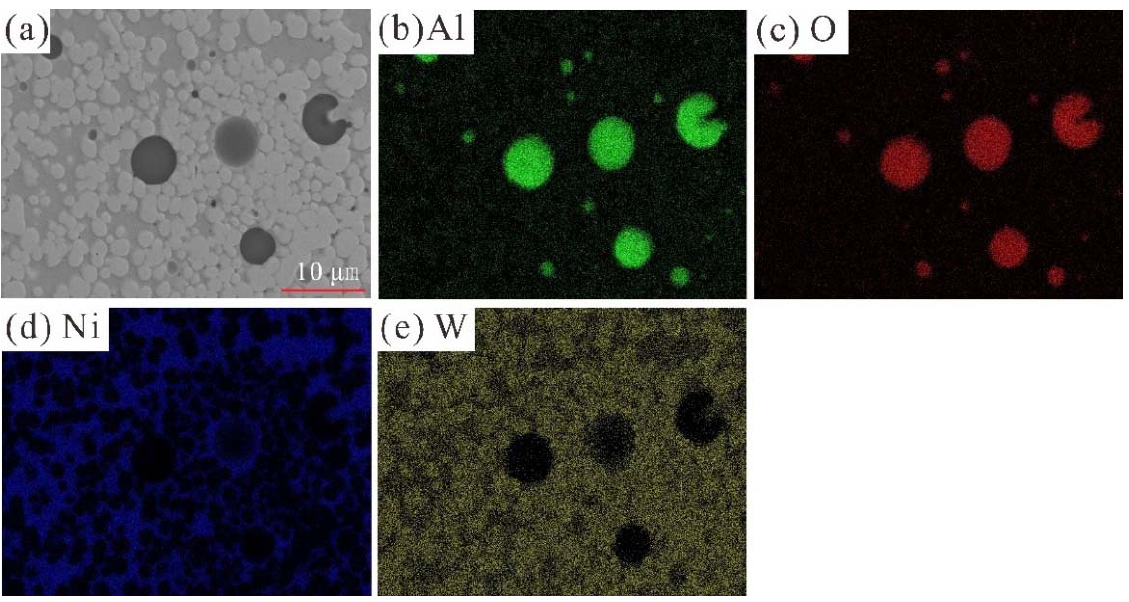
Figure 8. Elemental mapping of recovered (48Al–52Ni) 100 ‐ x W x fragments.